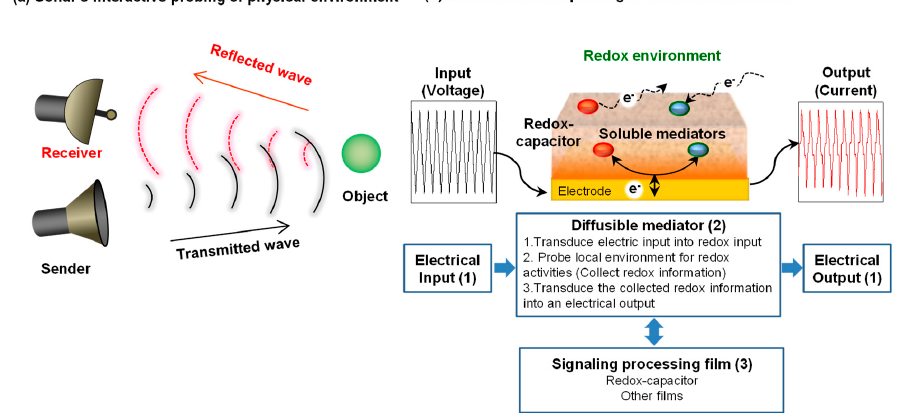
Figure 1. Interactive probing of a local environment. ( a ) Sonar analogy. ( b ) Interactive electrochemical probing consists of: ( 1 ) complex inputs/outputs to tailor the interactive probing; ( 2 ) diffusible mediators (electron shuttles) to transmit redox signals that can probe information; and ( 3 ) signaling processing film to facilitate information processing.